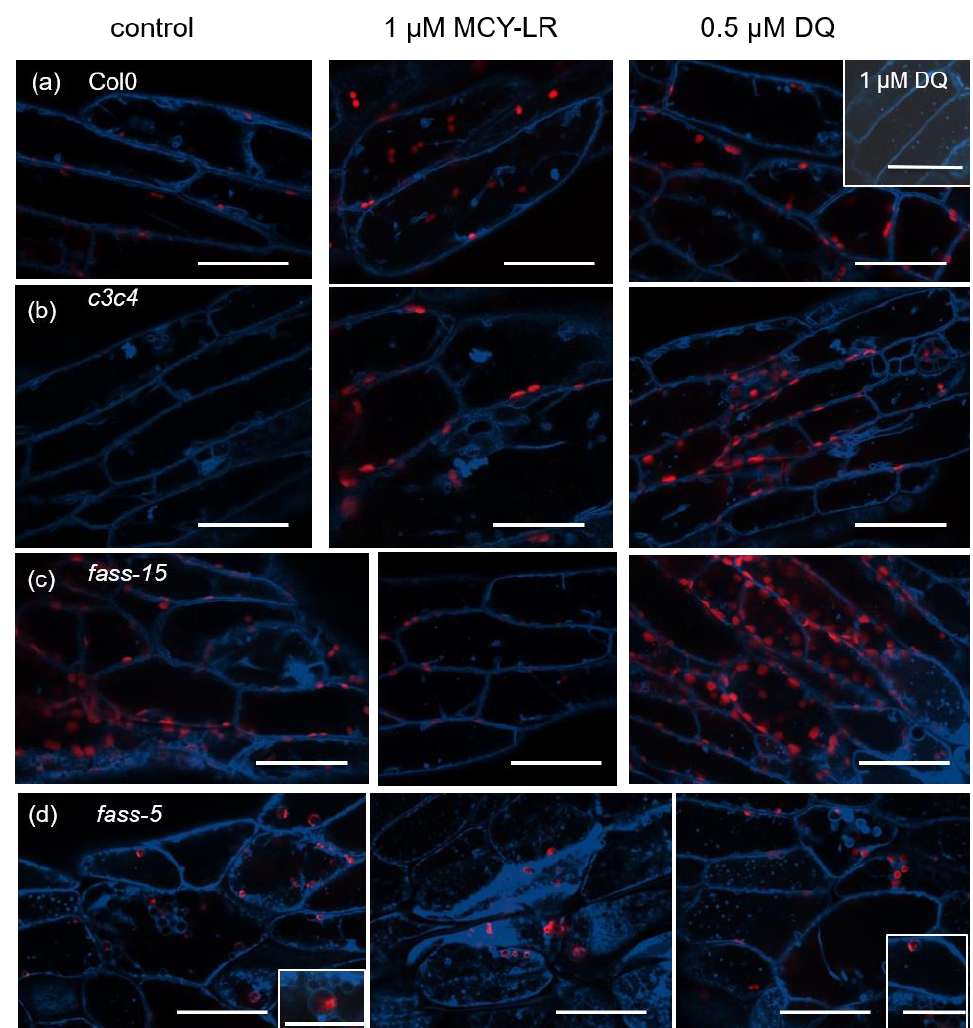
Figure 2. The organization of tonoplast systems of several Arabidopsis PP2A-related mutants is more sensitive to 24 h MCY-LR and DQ treatments than those of wild-type plants. Composite CLSM images of hypocotyls showing chlorophyll autofluorescence (red) and tonoplasts labeled with ACAIN (blue). ( a ) Col0, ( b ) c3c4 , ( c ) fass - 15 and ( d ) fass-5 . ( a ) In the Col0 wild-type hypocotyls, no visible effect could be detected after toxin treatments in general. Only a high concentration (1 µM) of DQ induced an increase in the occurrence of small tonoplast-coated vesicles (called “vesicularization”). ( b ) In c3c4 , controls show tonoplast-coated small vesicles. Their occurrence increased in the presence of MCY-LR and DQ induced intense vesicularization. ( c , d ). Increase of vesicularization in the fass mutants. This is true for controls, and the phenomenon intensified at MCY-LR and DQ treatments. This vesicularization/vacuole fragmentation process was more intense in fass-5 and cul- minated at MCY-LR treatment ( d ). Inset picture in ( d , control) shows a chloroplast entrapped in a tonoplast-coated vesicle. Scale bars: 50 µm.